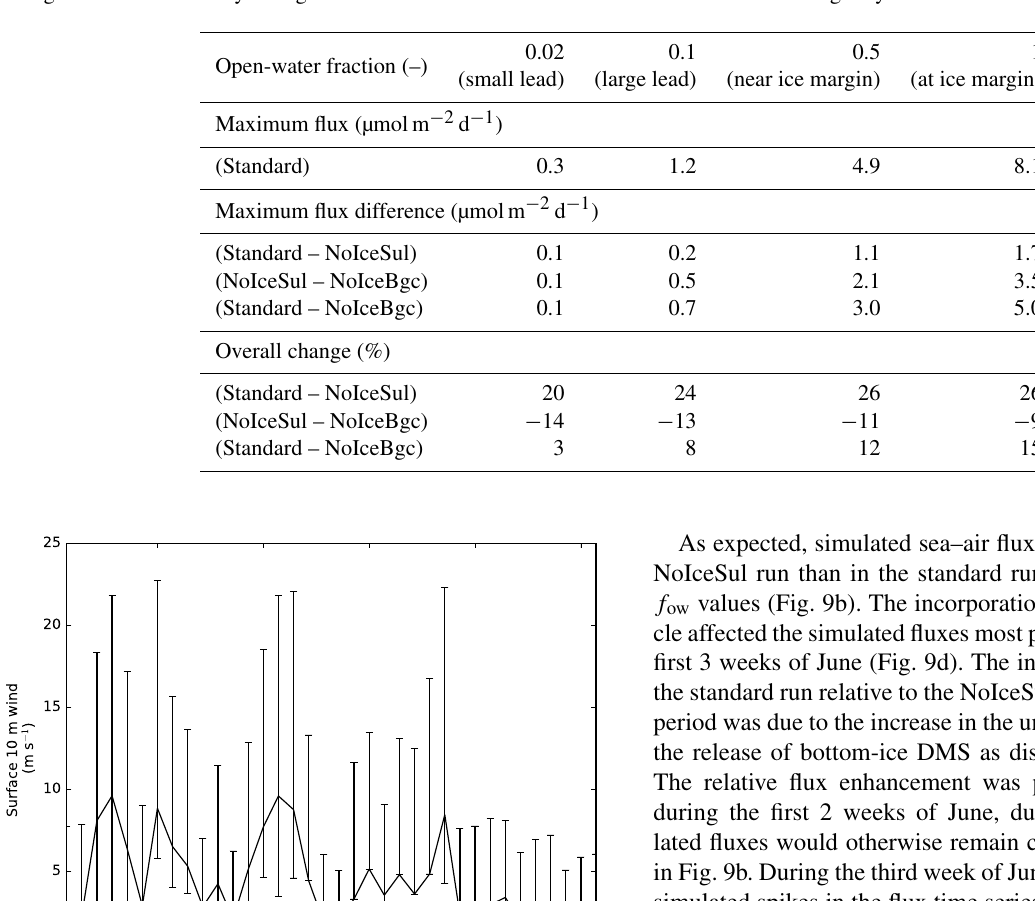
Table 5. Sensitivity of simulated sea–air DMS fluxes to the open-water fraction and to the incorporation of sea-ice biogeochemistry. Overall changes were calculated by taking the difference between the two runs of interest and dividing it by the cumulative flux in the subtracted run.